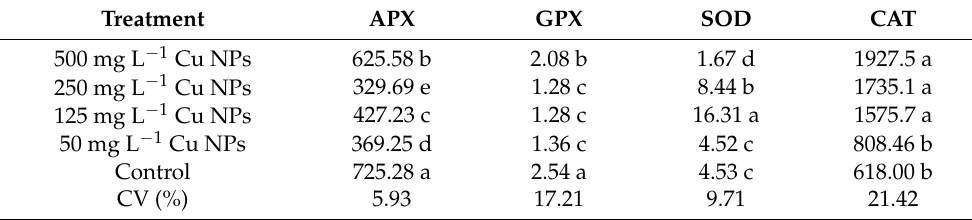
Each unit of data is the average of six replicates. CV: coefficient of variation. Different letters per column indicate significant differences between treatments according to the LSD Fisher test ( p ≤ 0.05). APX: ascorbate peroxidase (U total proteins − 1 (mg g − 1 )), GPX: glutathione peroxidase (U total proteins − 1 (mg g − 1 )), SOD: superoxide